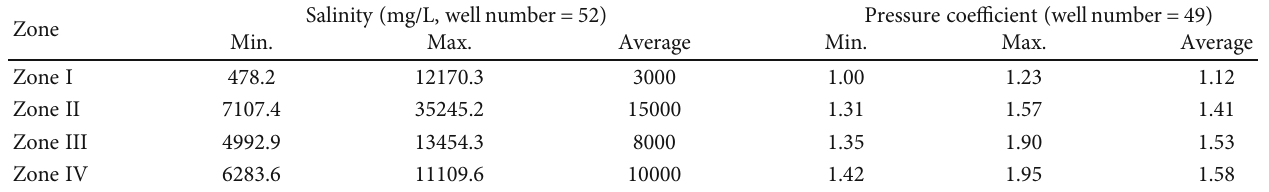
Table 1: Salinity and pressure coe ffi cients for the Triassic Baikouquan Formation in the study area. Salinity (mg/L, well number = 52 ) Pressure coe ffi cient ( wellnumber = 49 ) Zone Min. Max. Average Min. Max.